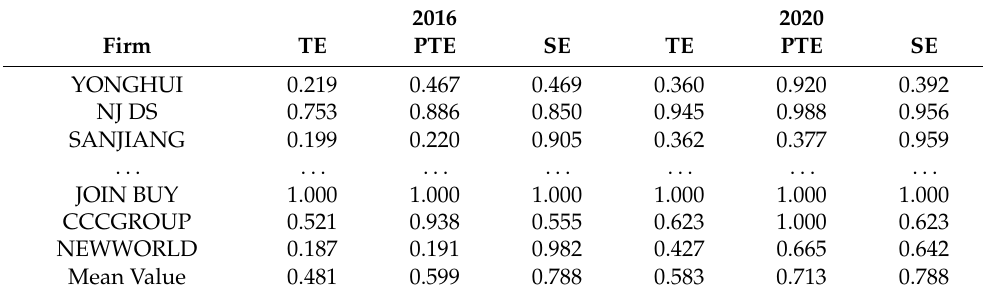
Table A6. The efficiency measurement results of 20 enterprises using the new retail model.